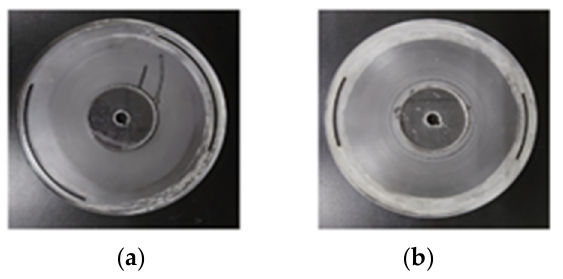
Figure 13. Pulse modulation discs with different duty cycles: ( a ) 1/2 duty cycle; ( b ) 1/4 duty cycle.